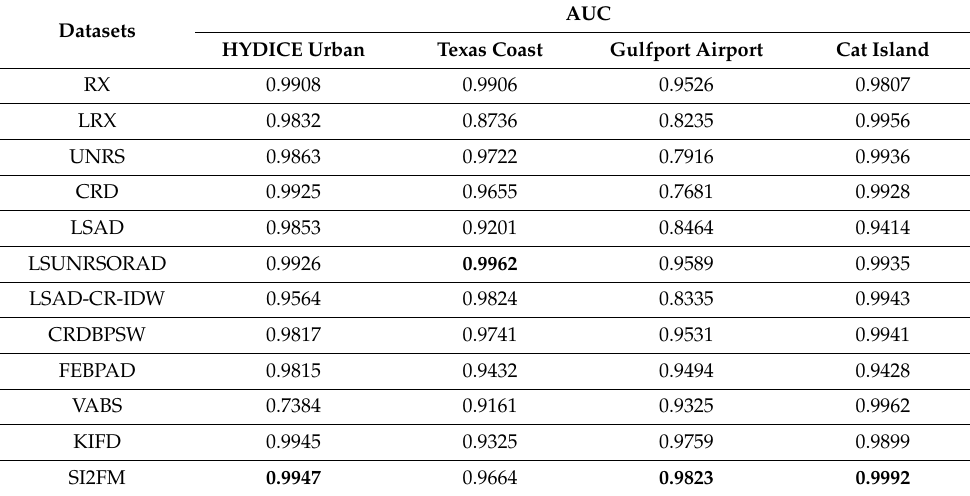
Table 3. AUC of each algorithm for four